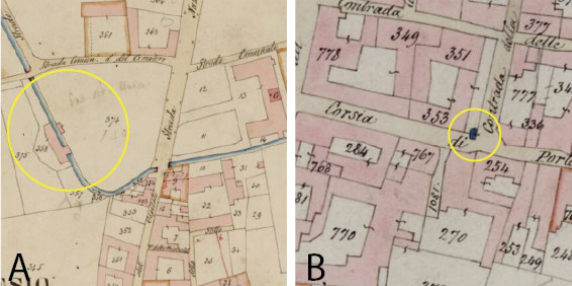
Figure 9. Maps of Cadastre Lombardo-Veneto , water elements highlighted in blue A) in Desio (canal) and B) Vimercate